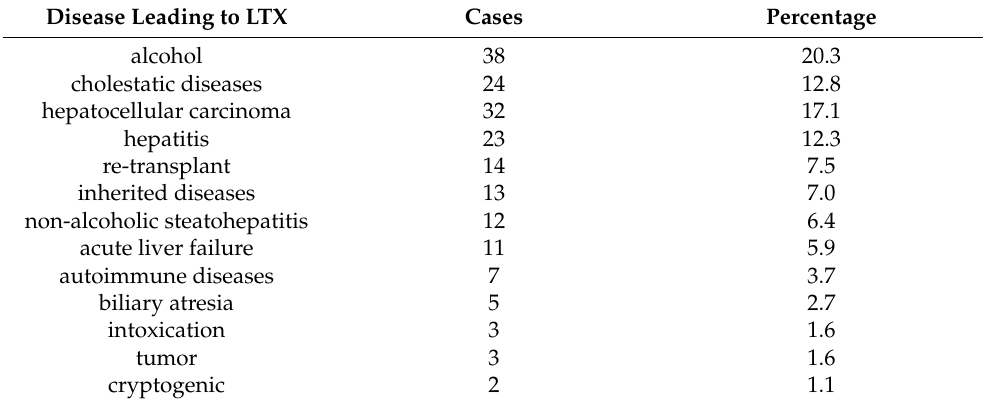
Table 1. Diseasesleadingtolivertransplantation. Frequenciesaregiveninabsolutevaluesandpercentages. Disease Leading to LTX Cases